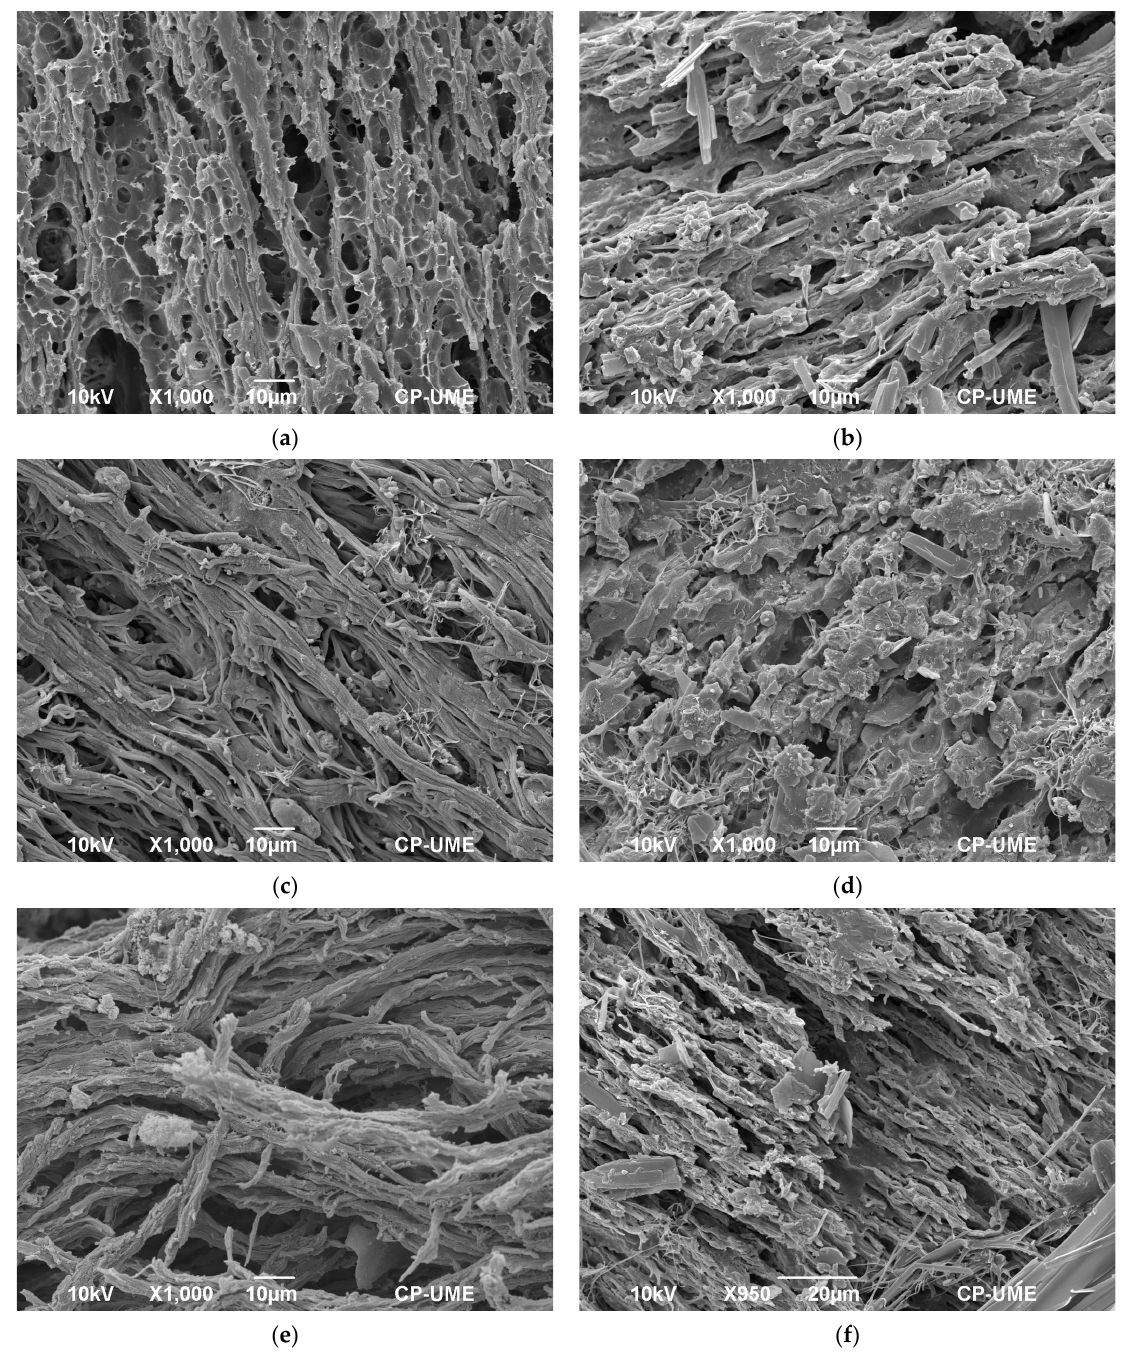
Figure 6. Scanning electron micrographs of Oaxaca cheese made with ultrasonicated raw milk (HIU) after 1 d of storage at 4 °C. ( a ) 25 kHz for 0 min HIU, ( b ) 45 kHz for 0 min HIU, ( c ) 25 kHz for 15 min HIU, ( d ) 45 kHz for 15 min HIU, ( e ) 25 kHz for 30 min HIU, ( f ) 45 kHz for 30 min HIU. Figure 6a shows the parallel strands of casein with channels between strands con- taining whey, including empty spaces in the matrix. Empty spaces in the phosphocasein matrix have been associated with the absence of fat globules and whey in pasta filata